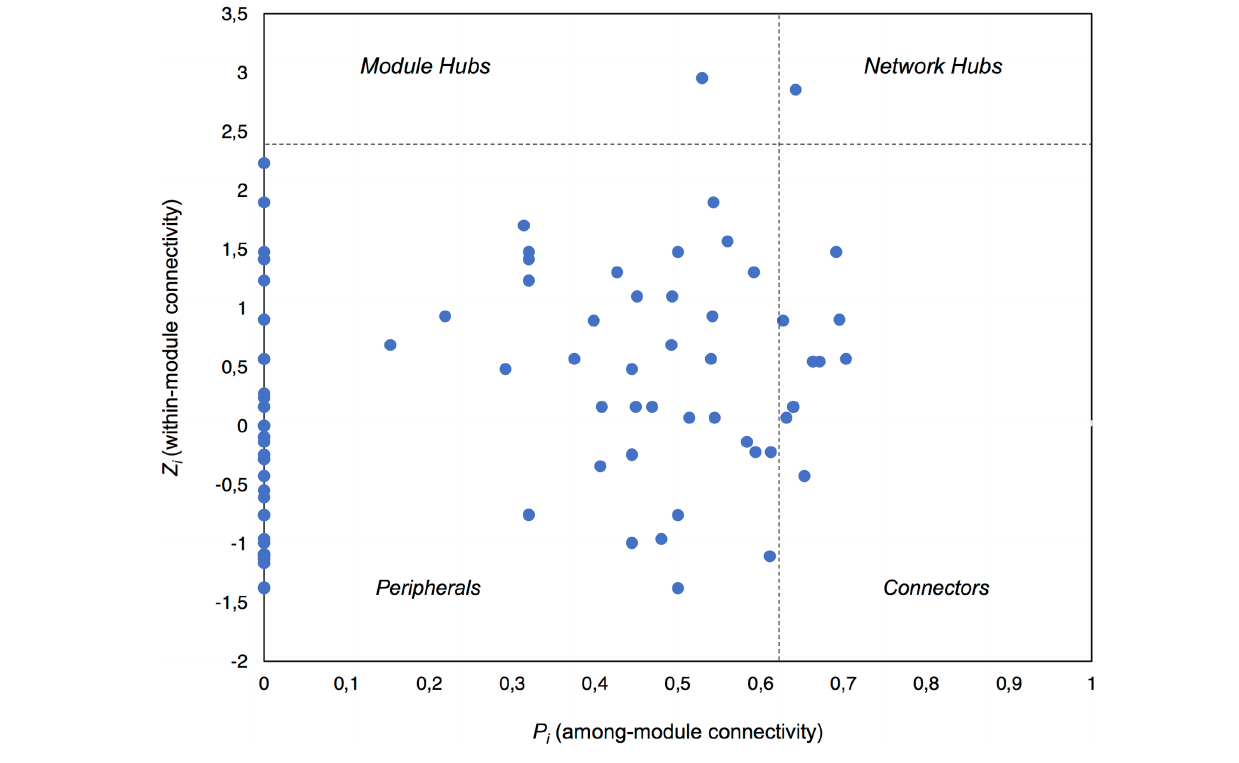
FIGURE 5 | Plot showing the topological roles of the taxa in the complete active network. Each taxon is shown as a dot in the dataset. The topological role of each taxon was determined using the Zi (within-module connectivity) and Pi (among-module connectivity) scores in the scatterplot (Deng et al.,